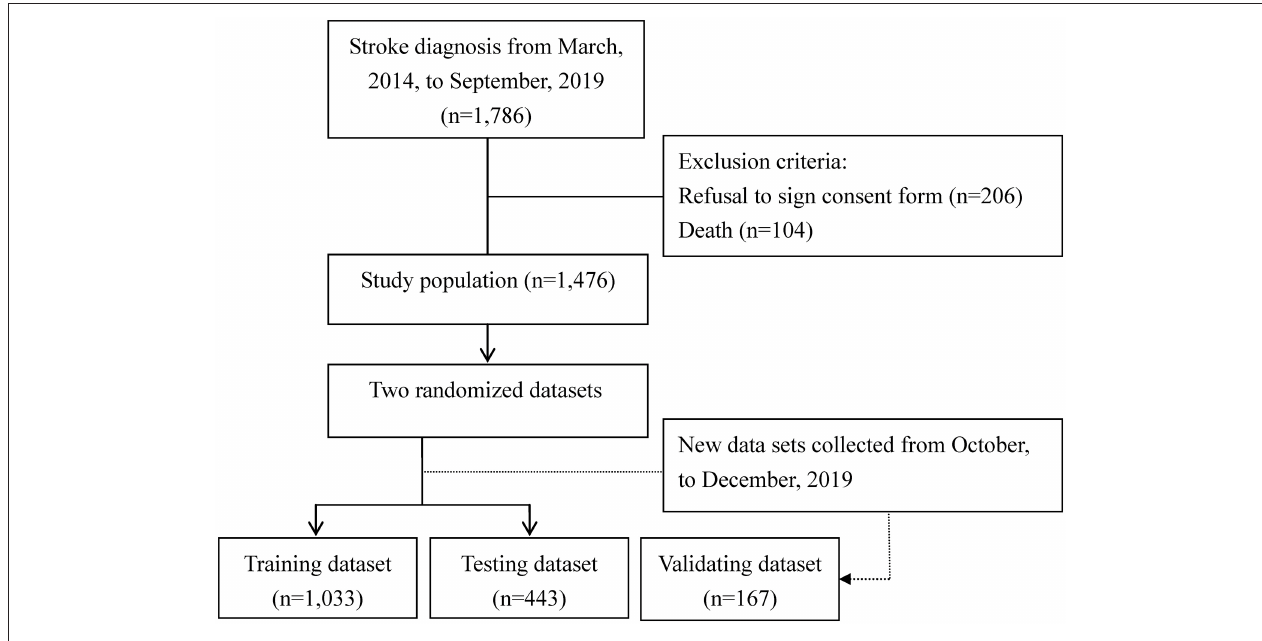
FIGURE 1 | Flowchart of the study.